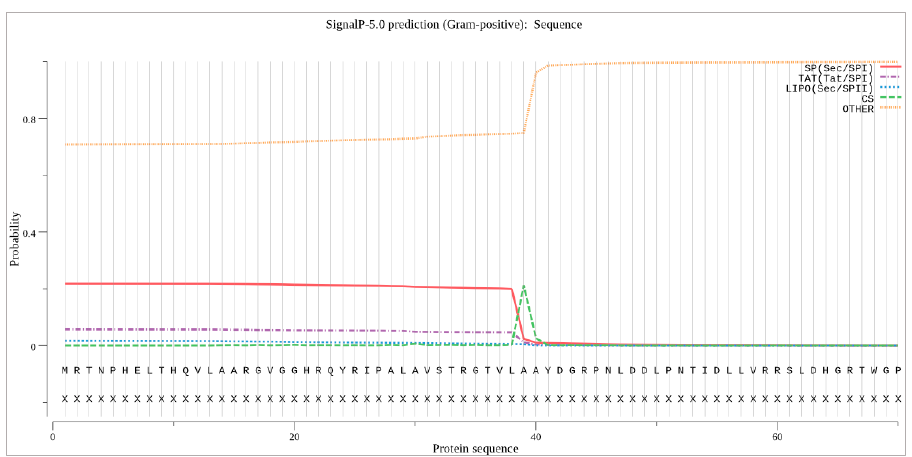
Figure 10. Signal peptide of O. paurometabola O129 sialidase as predicted with high probability by SignalP 5.0 software. The cleavage site LAA is marked by a green peak.